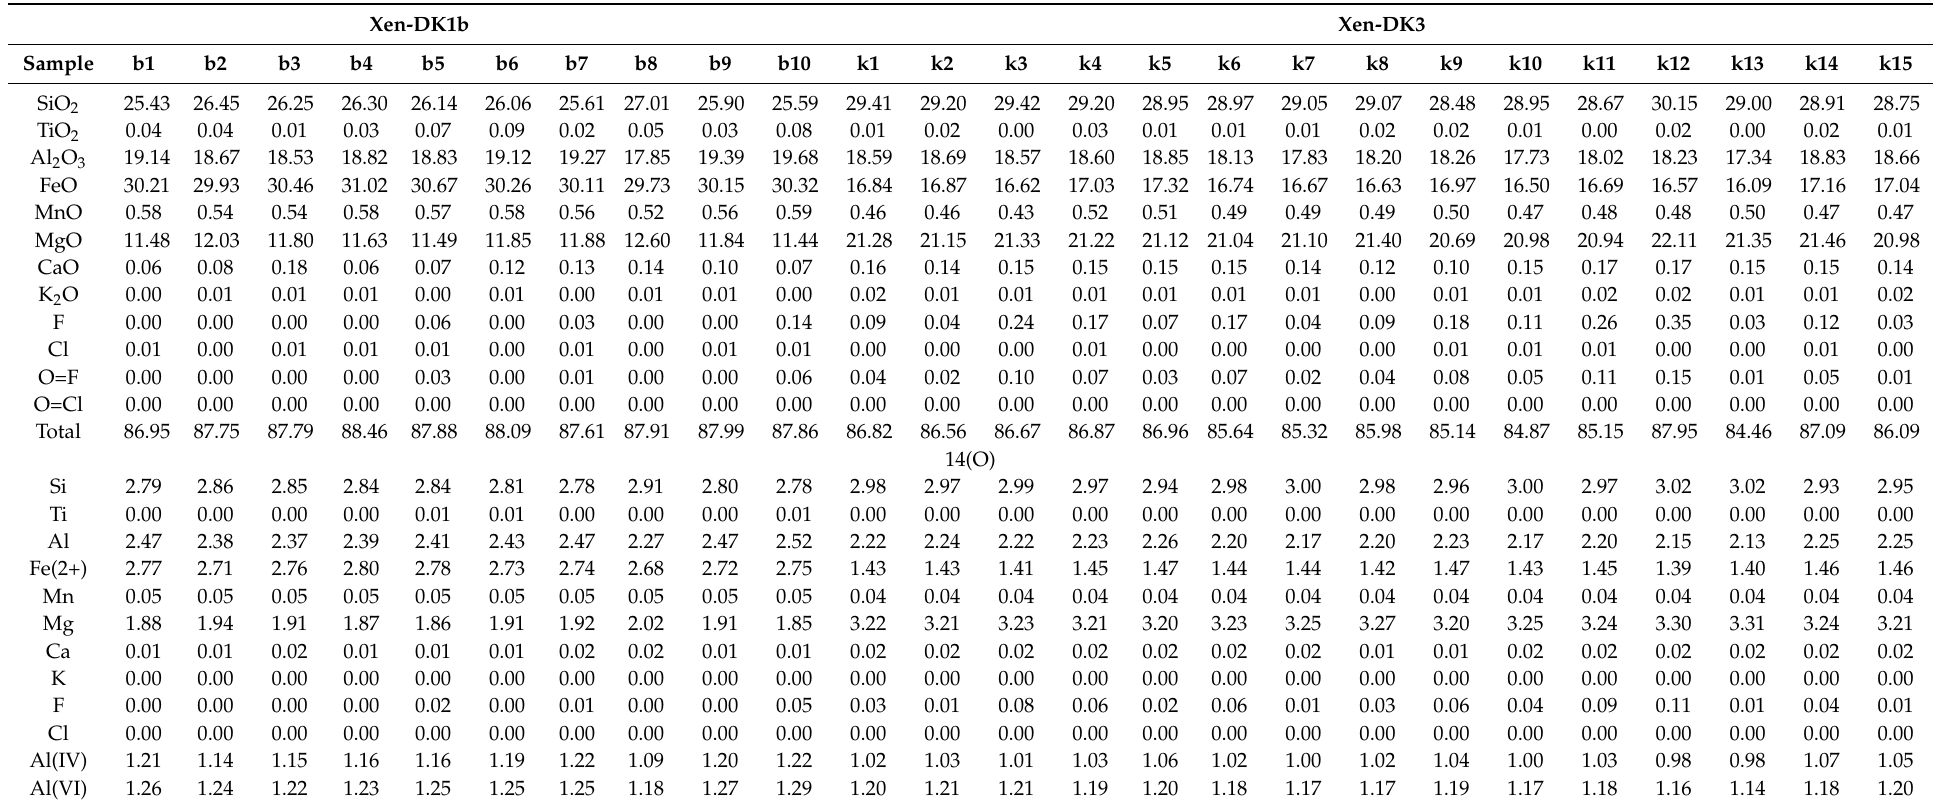
Table 2. Representative major-element compositions of chlorite from studied diorite and microdiorite